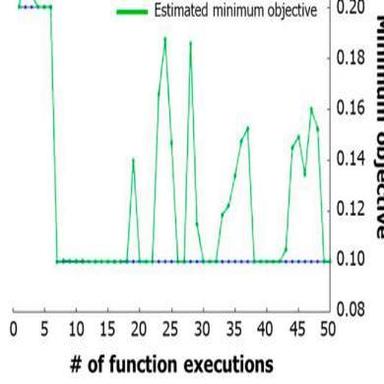
Performance evaluation results for the optimized CNN-based deep learning model for failure characterization.